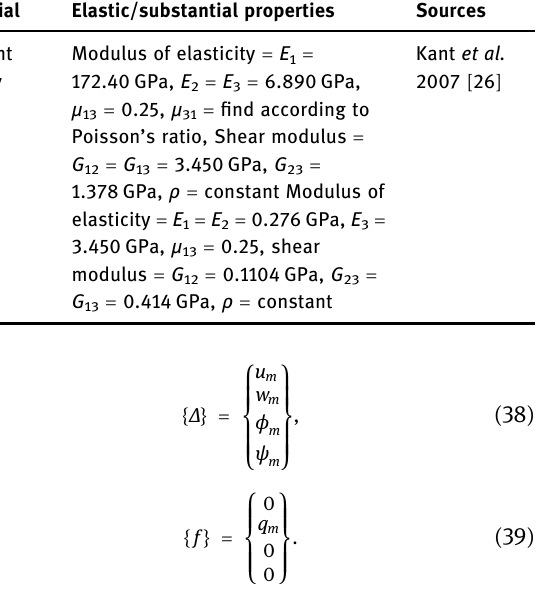
Material Elastic/substantial